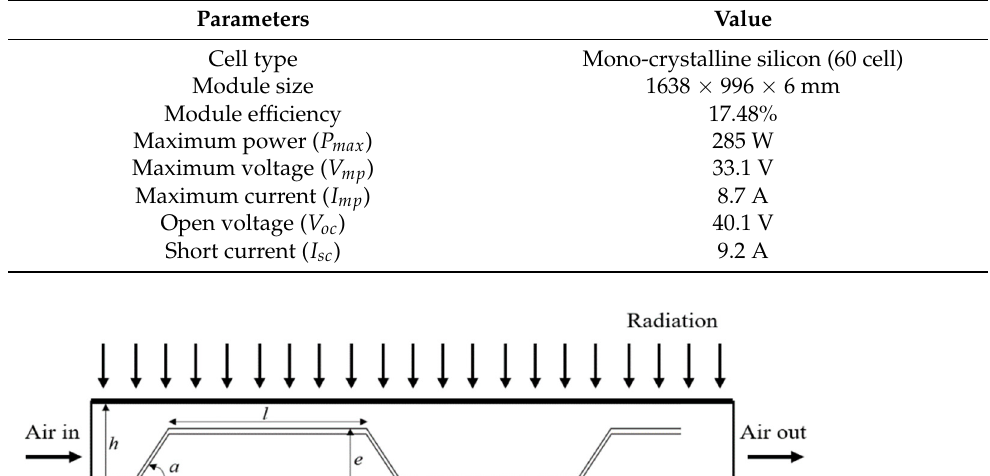
Figure 4. Scheme for Experiment of air-type PVT collector. Table 2. Specifications of the measuring equipment. Type Specification Solar irradiance (Pyranometer)